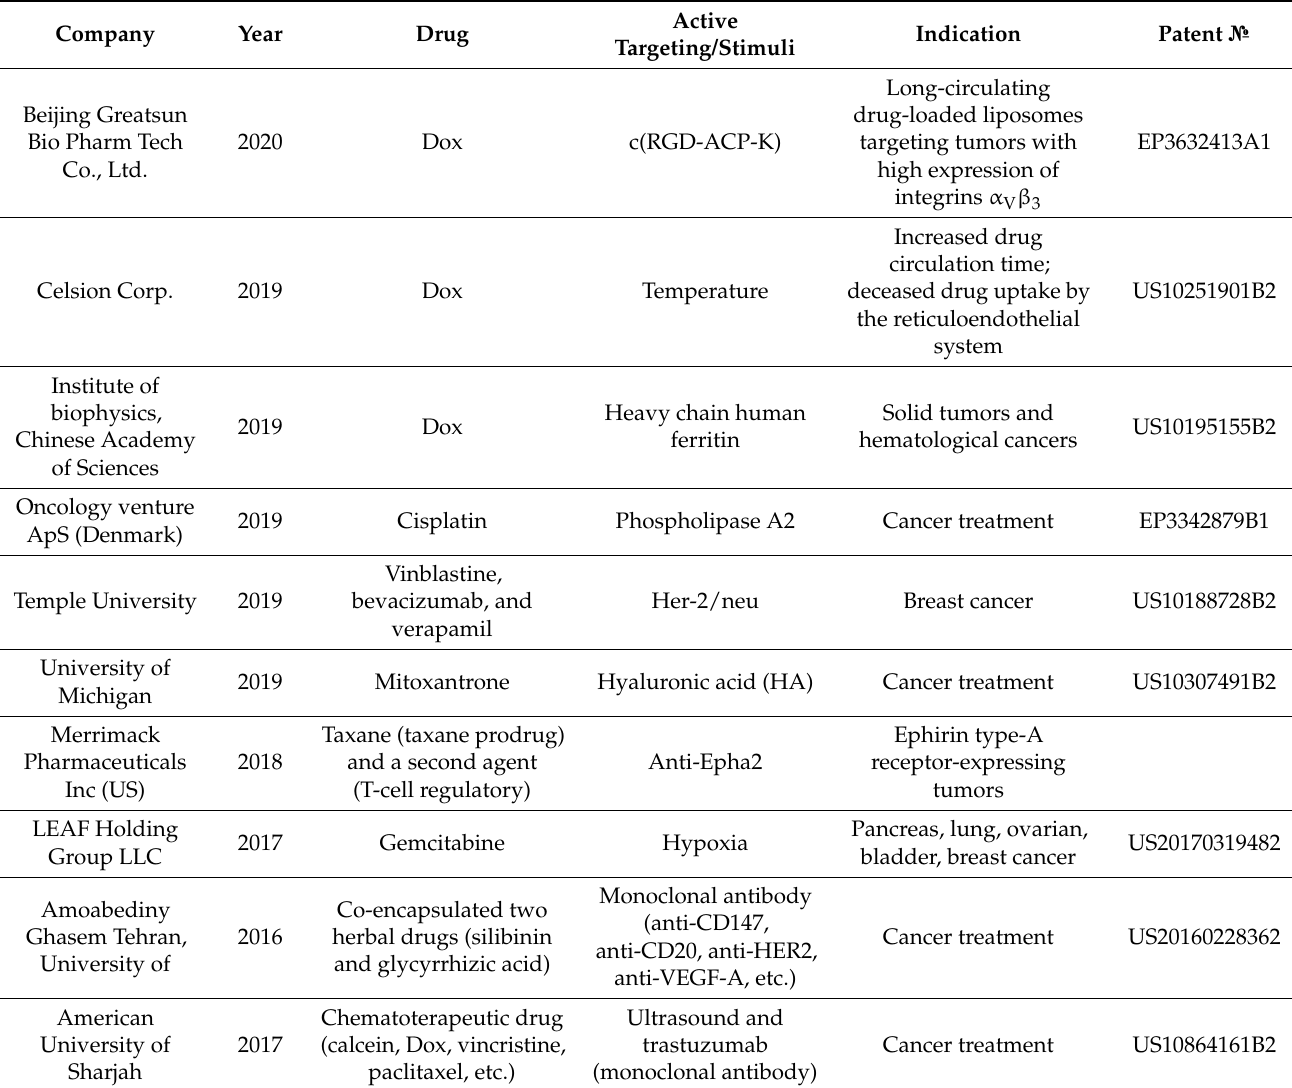
Table 2. Overview of recently registered patents on targeted liposome